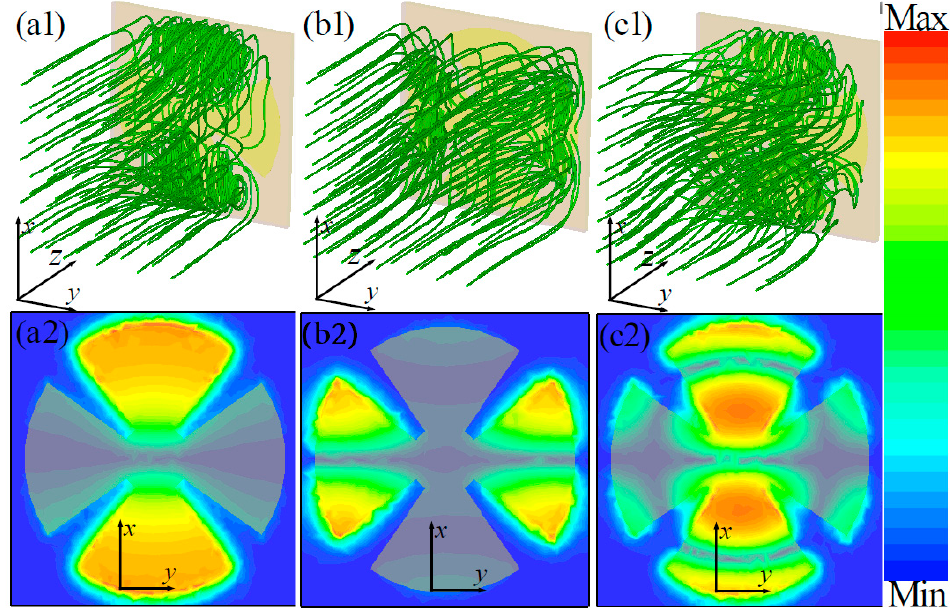
Figure 5. The distributions of ( a1 – c1 ) power-flow streams and ( a2 – c2 ) power-loss density of the unit-cell structure at different resonant frequencies: ( a1 , a2 ) f 1 = 3.35 GHz; ( b1 , b2 ) f 2 = 8.65 GHz; and ( c1 , c2 ) f 3 = 12.44 GHz.